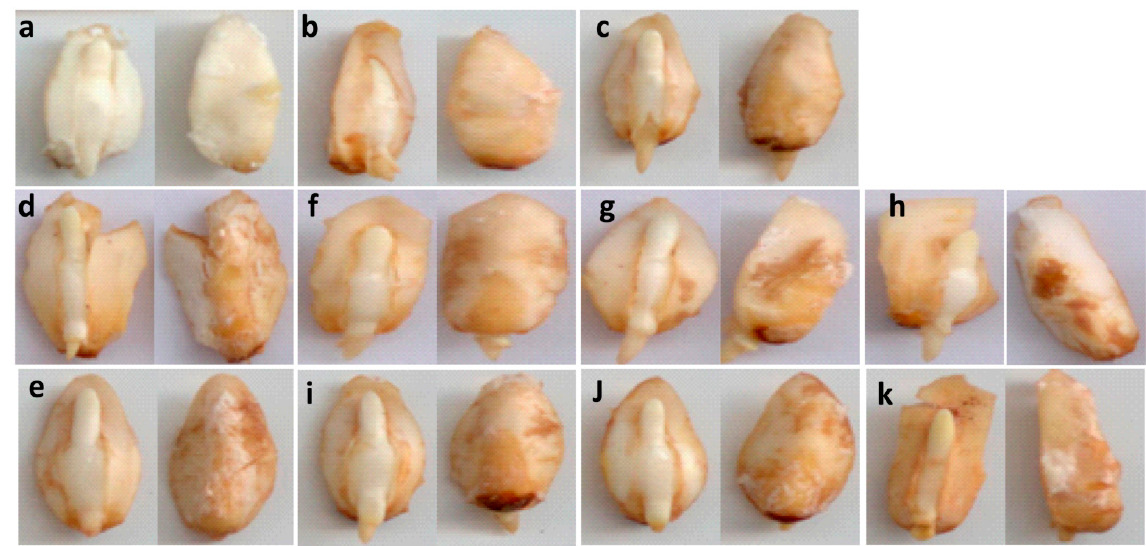
Figure 3. In situ location of reactive oxygen species (ROS). 3,3 ′ -Diaminobenzidine (DAB) staining for the detection of mainly H 2 O 2 in embryos imbibed for 24 h in different media. ( a ), Unstained embryo; ( b ), H 2 O at pH 6.8; ( c ), H 2 O+H + at pH 4.5; ( d ), Pi; ( e ), Cit; ( f ), Pi+Zn1; ( g ), Pi+Zn10; ( h ), Pi+Zn50; ( i ), Cit+Zn1; ( j ), Cit+Zn10; and ( k ), Cit+Zn50.